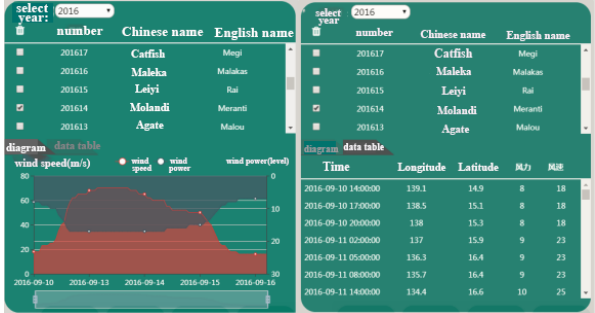
Figure 5.Typhoon information statistical diagram, data